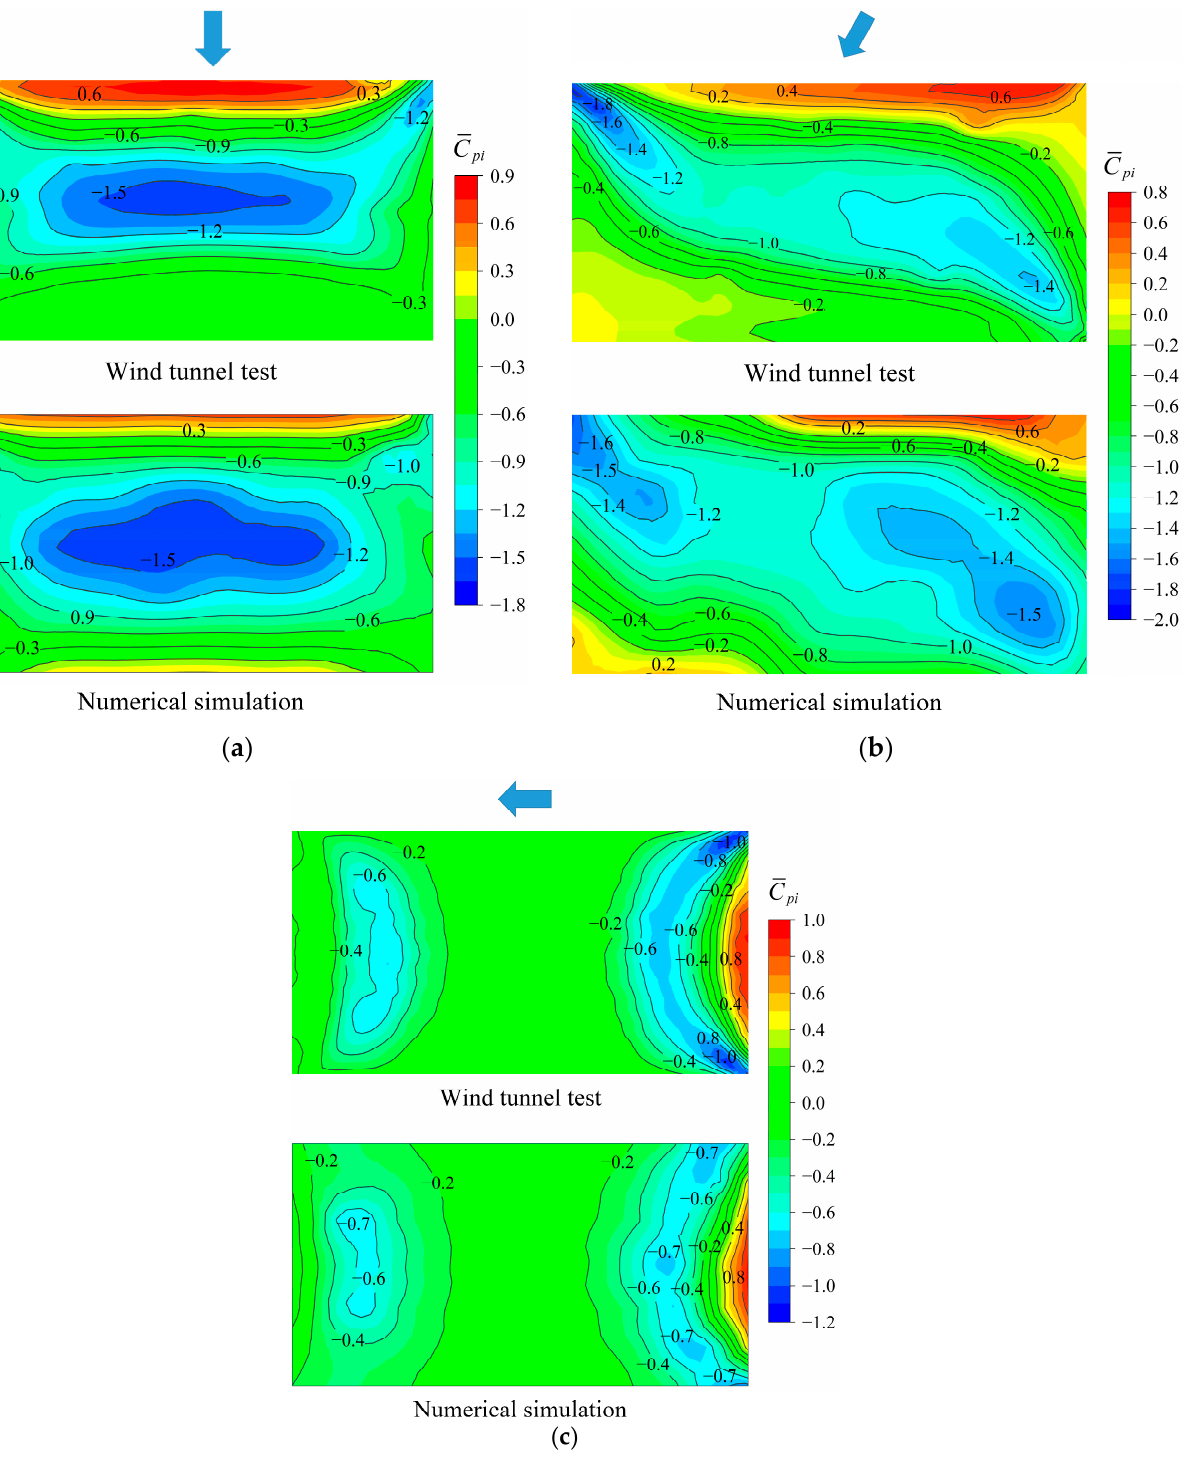
Figure 13. Comparisons of mean wind pressure coefficients obtained from wind tunnel test and numerical simulation: ( a ) 0° wind direction; ( b ) 30° wind direction; ( c ) 90° wind direction.